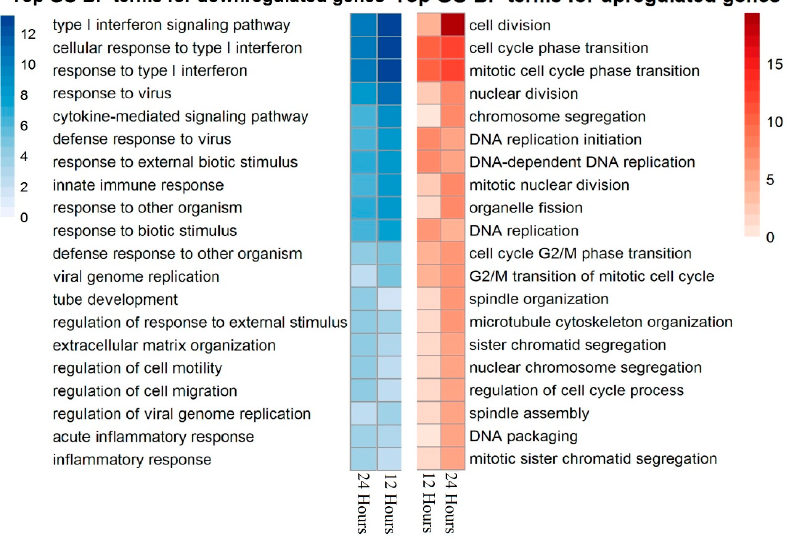
Figure 3. GO BP down/upregulated genes heatmap, 12 and 24 hours after PDGF ‐ BB treatment of human adipose ‐ derived MSCs. The values represent − log10( p ‐ value) for enrichment.